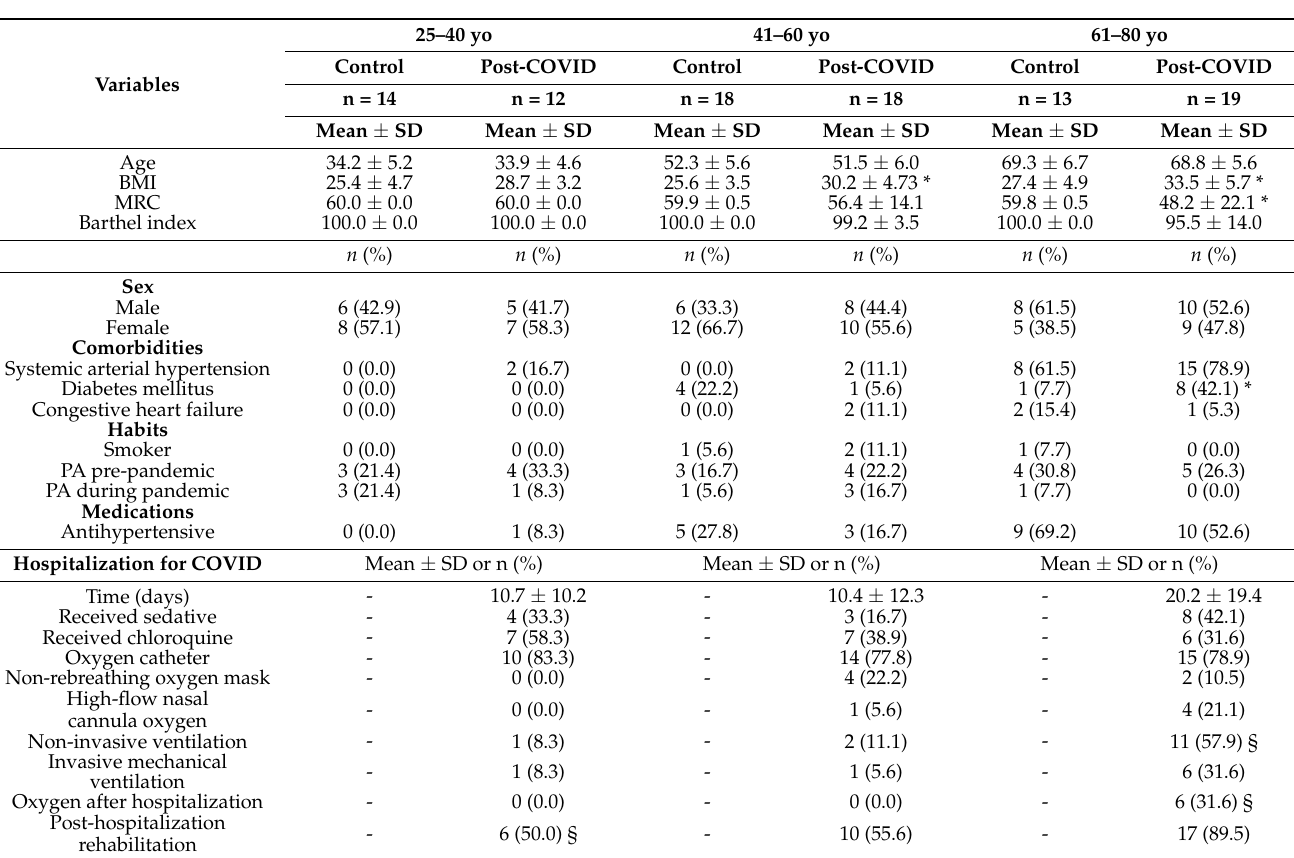
Table 1. Demographic